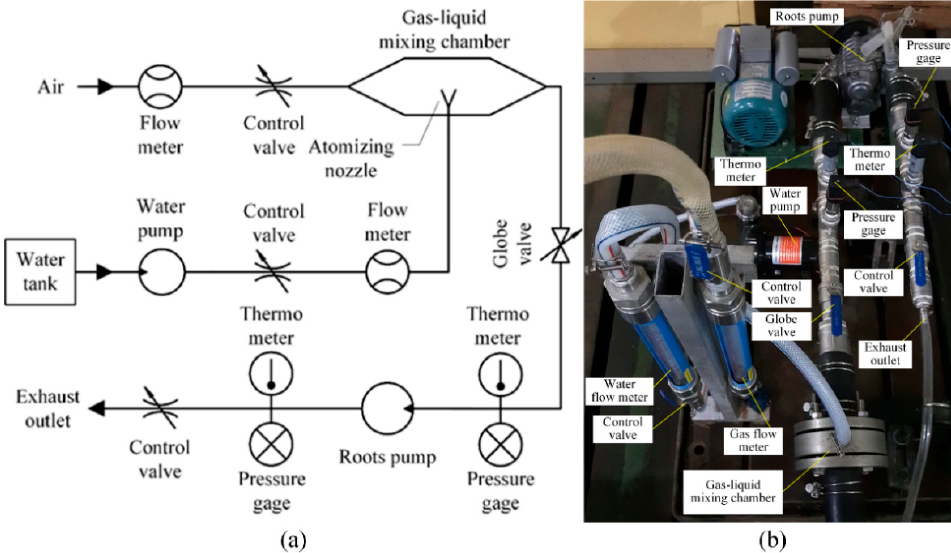
Figure 3. Schematic diagram ( a ) and photograph ( b ) of the experimental equipment. Reprinted with permission from ref. [7]. Copyright 2020 Elsevier.